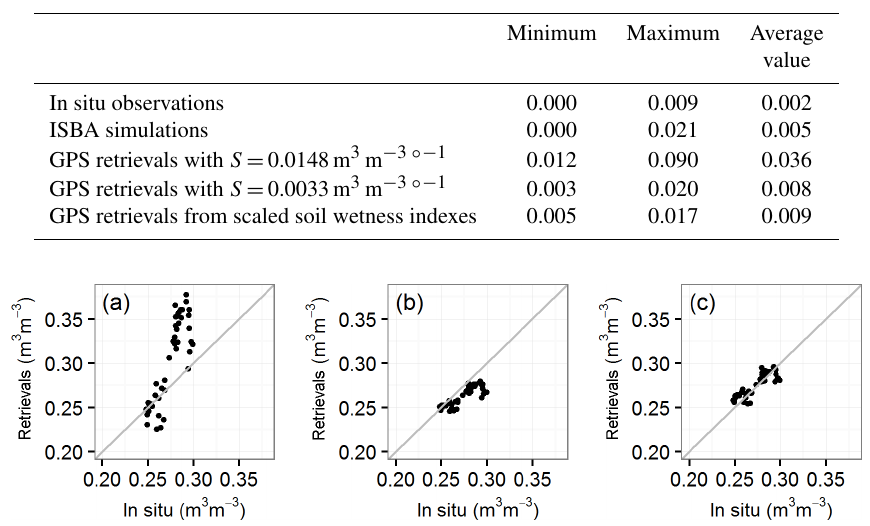
S = 0.0033 m 3 m − 3 ◦− 1 , and GPS retrievals from the scaled soil wetness index,